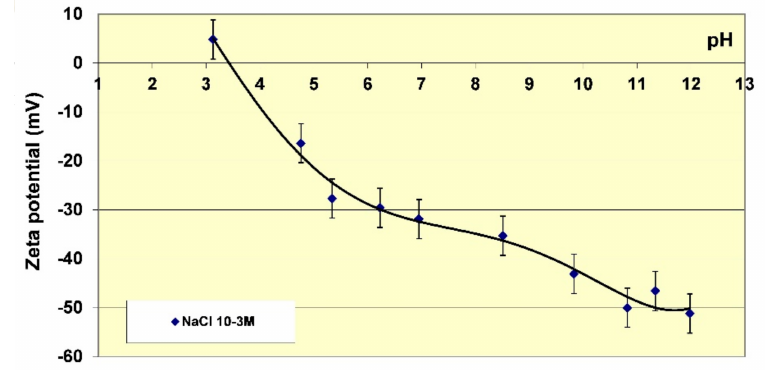
Figure 4. Zeta potential measurements of the kaolinite clay mineral used in this study, in NaCl (0.001 M) as a function of